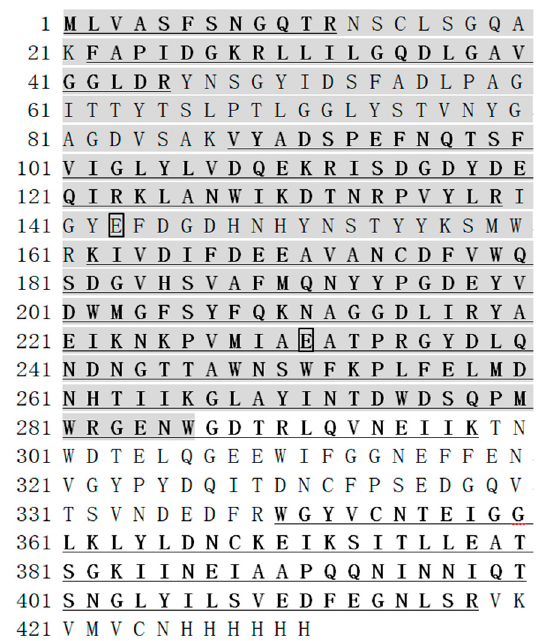
Figure 2. The sequence of the Xyl88. The LC-ESI-QUAD-TOF analysis results are underlined and in bold, the conserved GH26 catalytic domain shaded in gray and the catalytic residues are marked with a box.